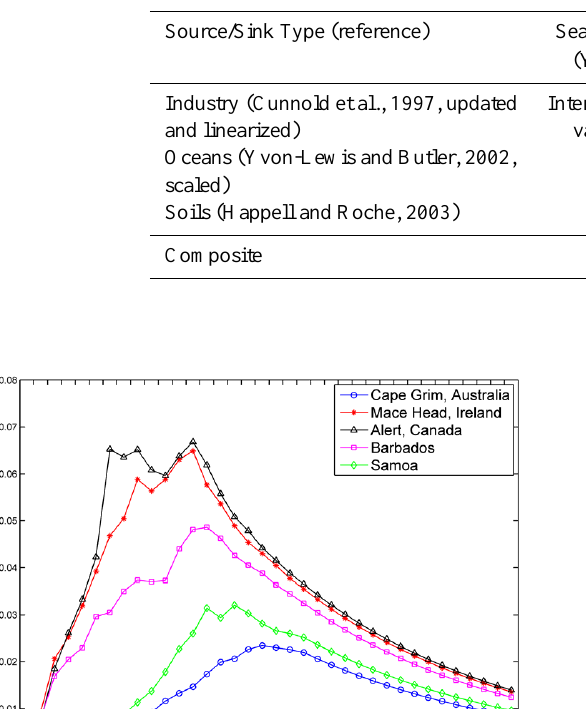
Table 3. Reference annual average magnitudes of the sources and sinks of atmospheric CCl 4 and their participation in the inversion (Y=yes and N=no).